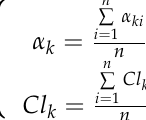
(b) Figure 16. Angle-averaged lift coefficients from each pitching angle case ( a ) and all the cases ( b ). 5.3. Comparison with 2D Wind Tunnel Data In order to minimize the 3D induction effect from blade root and tip, aerodynamic data of DU93- W-210 airfoil at r/R = 0.64 of the blade was chosen to compare with the 2D wind tunnel data, where R is the radius of rotor. The Reynolds number was computed by Equation (11), where V is the velocity measured by the corresponding seven-hole probe, P and T are the atmospheric pressure and